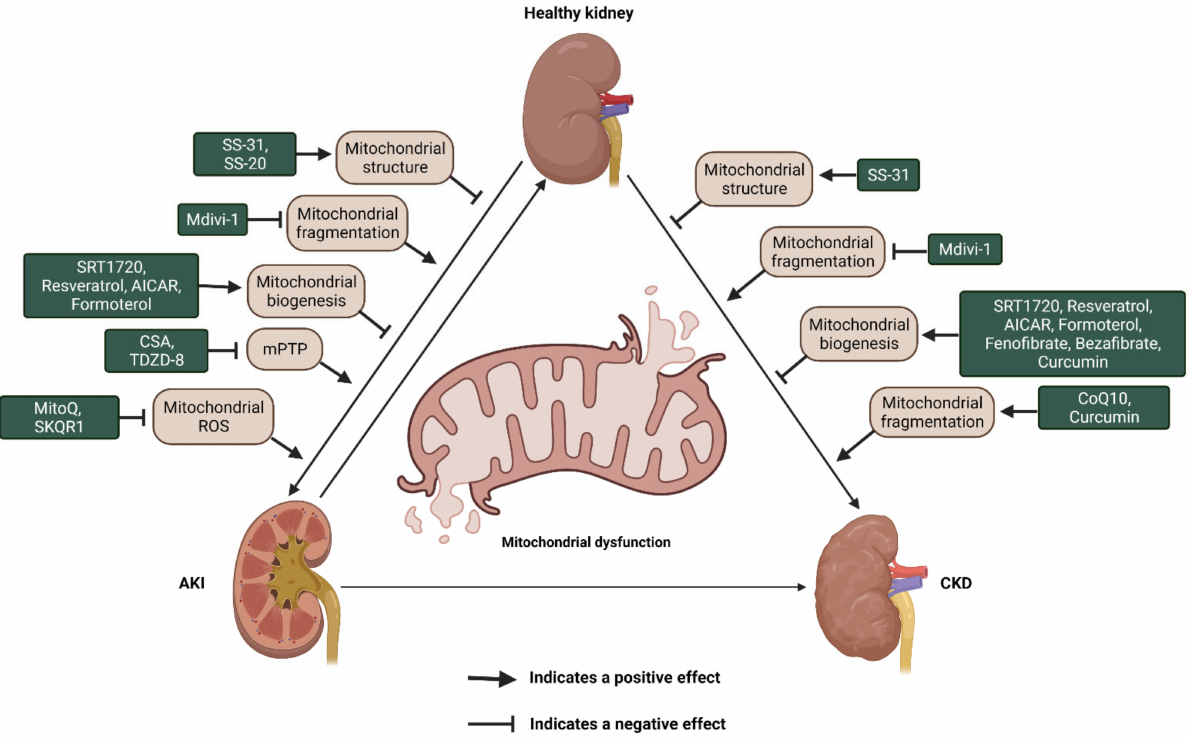
Figure 3. Schematic illustration of the potential compounds that target the dysfunction of mitochondrial structure, fragmen- tation and biogenesis as well as mPTP opening and mitochondrial antioxidant capacity in AKI and CKD. AKI: acute kidney injury; CKD: chronic kidney disease; ROS: reactive oxygen species. mPTP: mitochondrial permeability transition pore; CSA: Cyclosporine-A; TDZD-8: 4-benzyl-2-methyl-1,2,4-thiadiazolidine-3,5-dione; CoQ10: Coenzyme Q10 MitoQ: mitochondrial coenzyme Q; SkQR1: 10-(6 (cid:48) -plastoquinonyl) decylrhodamine